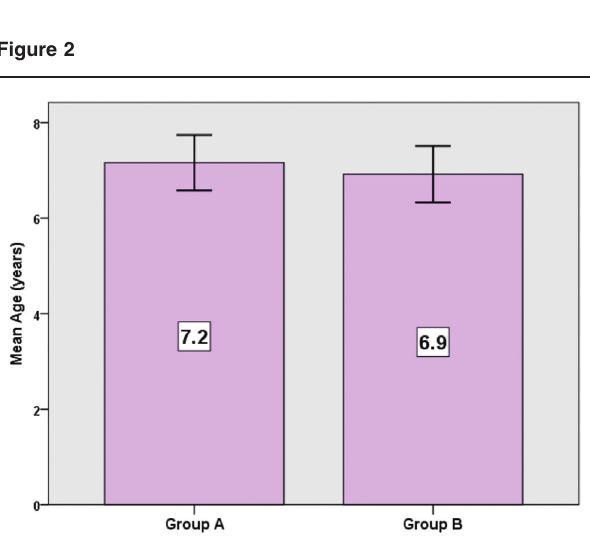
The mean age for both groups.